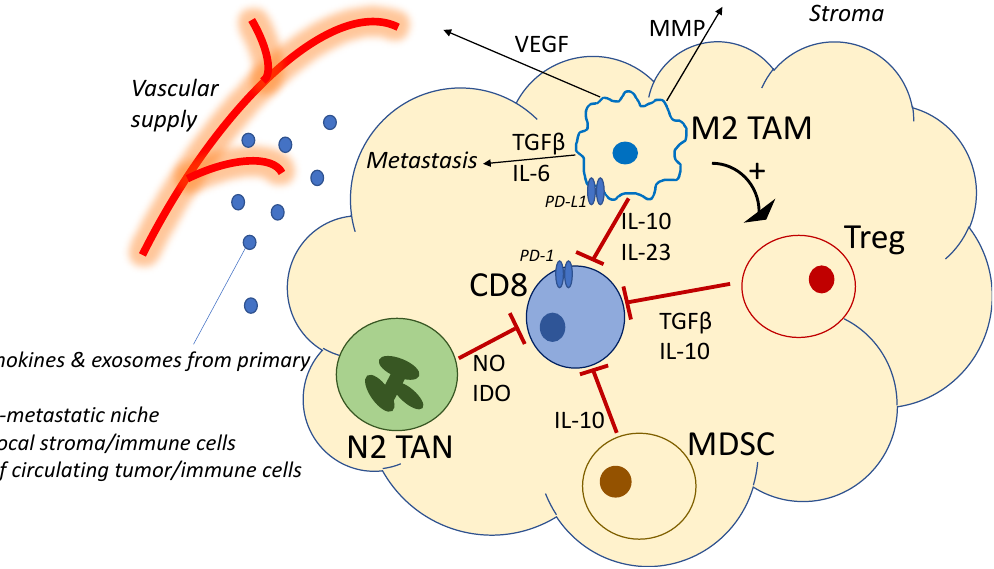
Figure 1. Cellular interactions in colorectal cancer metastasis. This proposed model illustrates the key changes in immune cells in an immunosuppressive tumour microenvironment, preventing surveillance, control and elimination of invading metastatic tumour cells. IDO, indoleamine 2,3-dioxygenase; IL, interleukin; MDSC, myeloid derived suppressor cells; MMP, matrix metalloproteinase; NO, nitric oxide; PD-1, programmed cell death receptor 1; PD-L1, programmed cell death receptor ligand 1; Treg, T regulatory cell; TAM, tumour associated macrophage; TAN, tumour-associated neutrophil; TGF, transforming growth factor; VEGF, vascular endothelial growth